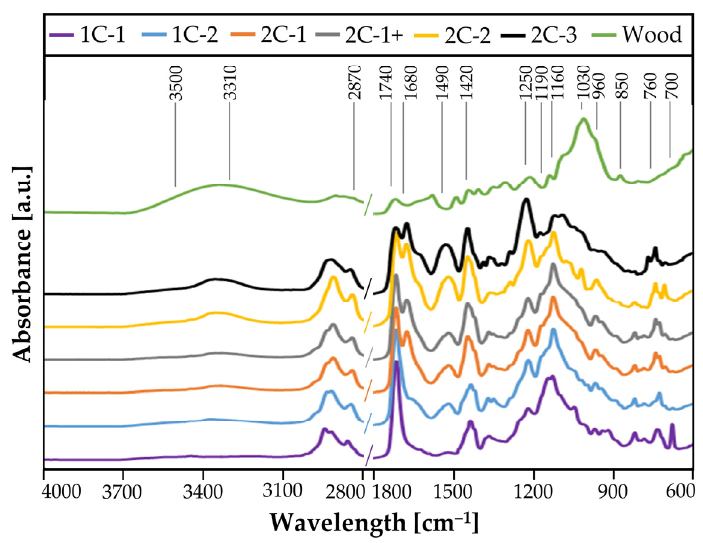
Figure 1. ATR-FTIR spectra in the wavelength regions from 4000 to 2800 cm − 1 and from 1800 to 600 cm − 1 .